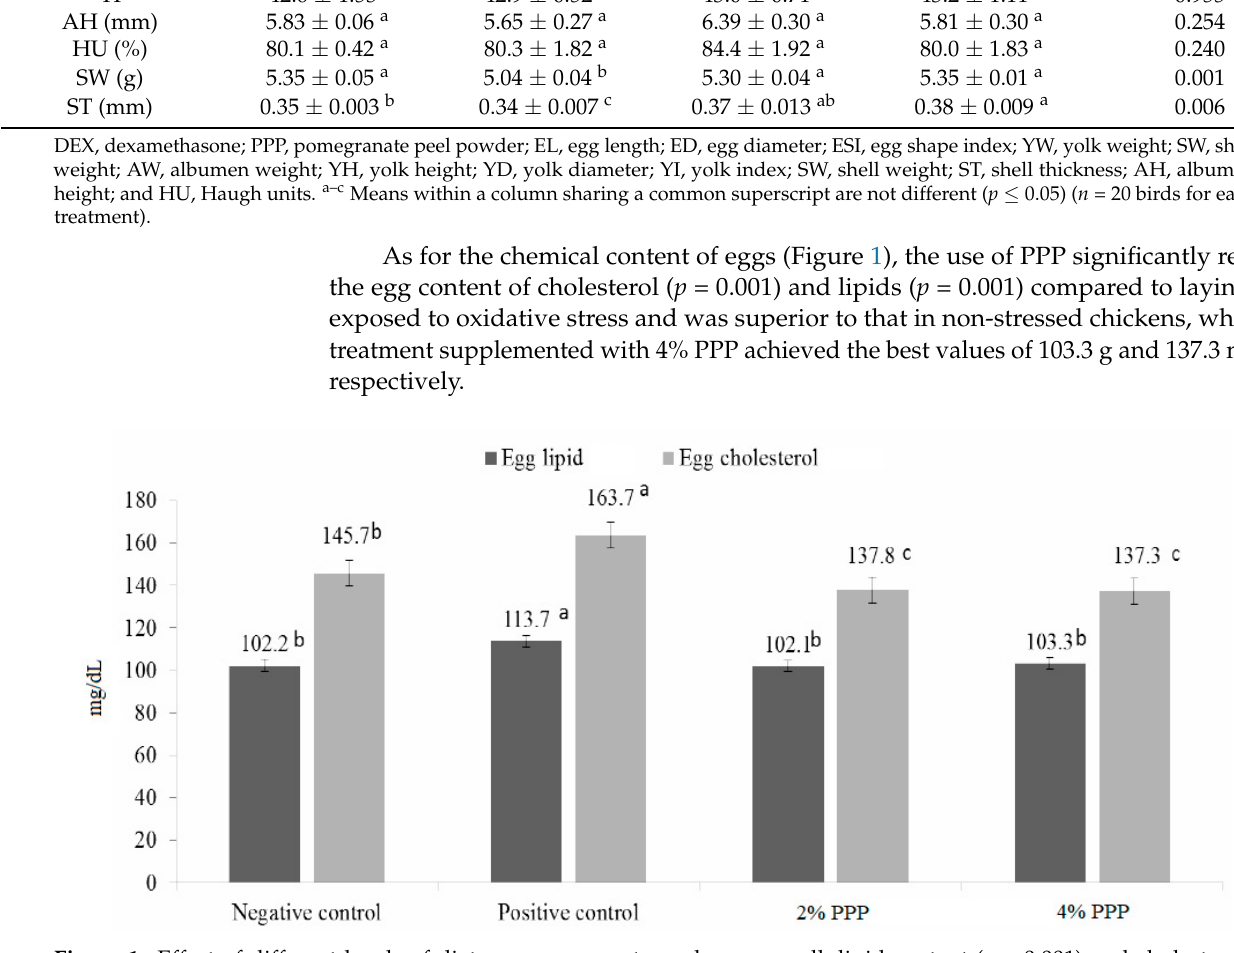
Table 5. Effect of different levels of dietary pomegranate peel on some biochemical parameters of laying hens subjected to oxidative stress.